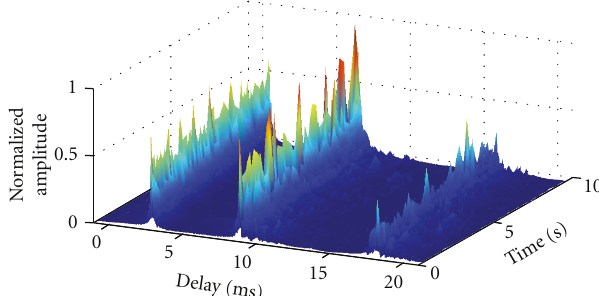
Figure 13: Spectrogram of the LFM signal transmitted by the towed source, demonstrating the multipath e ff ects of underwater propagation for the BASE07